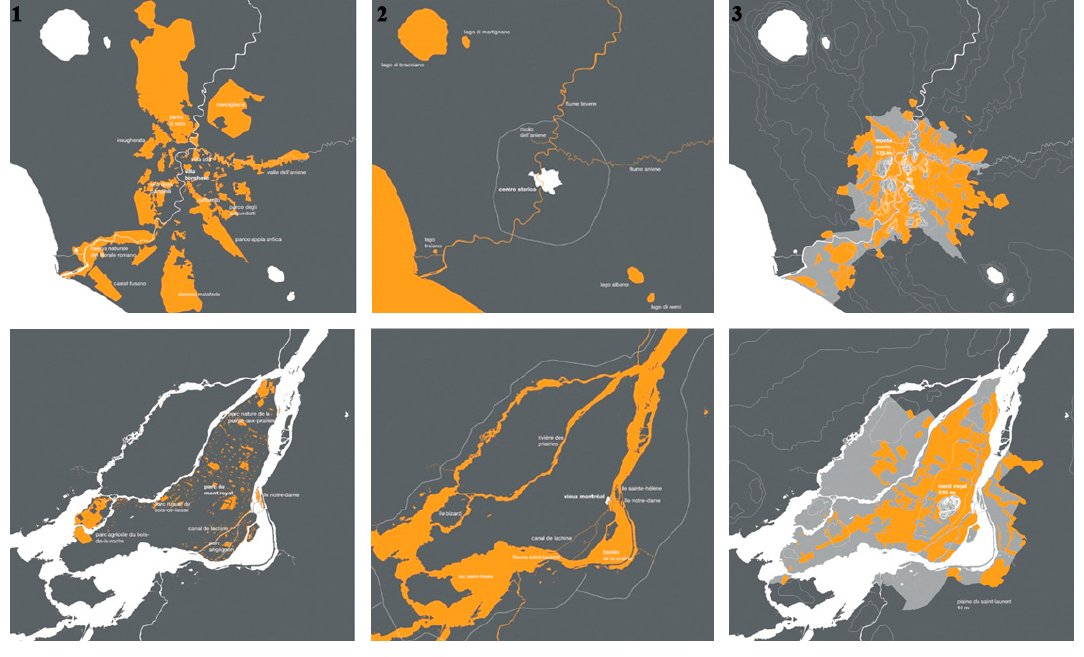
Figure 6. Vital elements: Left column : green areas; centre column : water; right column : air; top row : Rome; bottom row : Montreal (Source: authors)